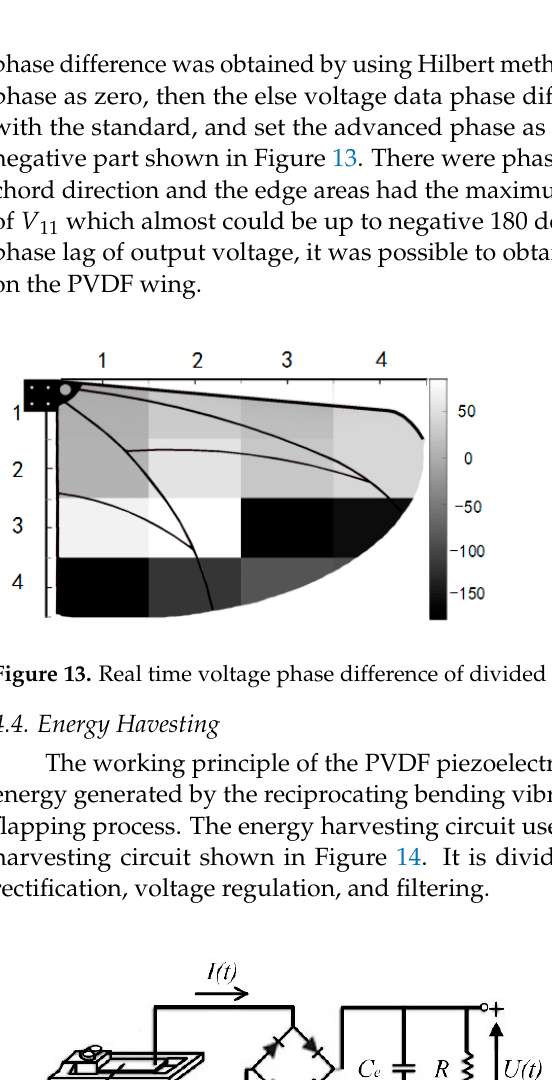
Figure 15. LED light supply experimental device.